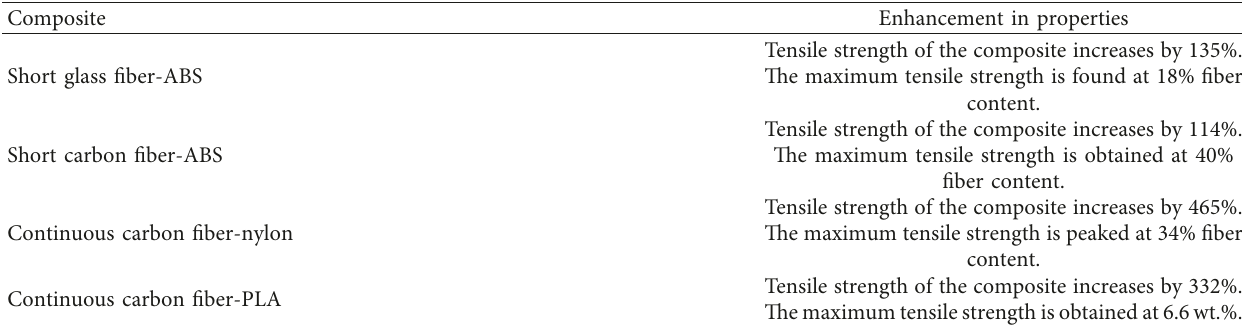
Table 2: Synthetic fiber reinforcement in polymer and their enhancement